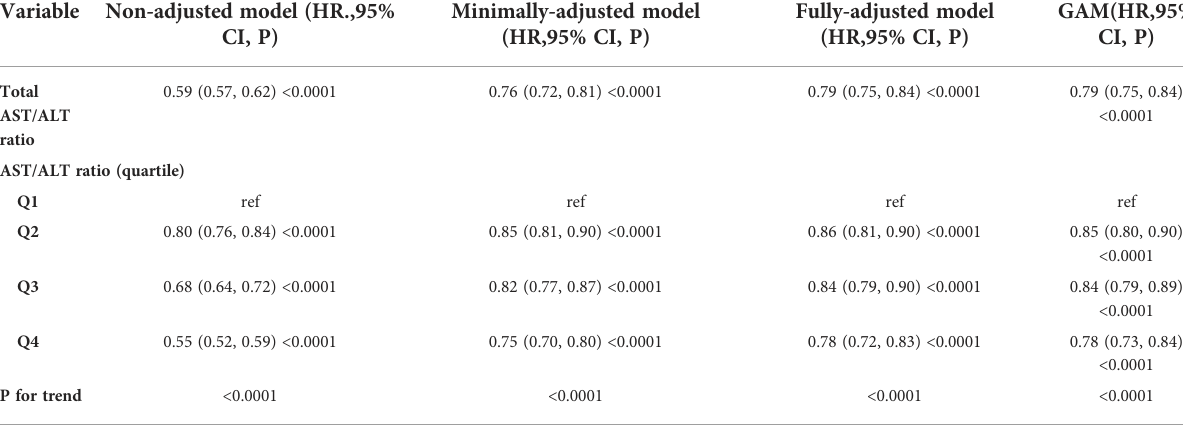
TABLE 4 Relationship between AST/ALT ratio and the incident prediabetes in different